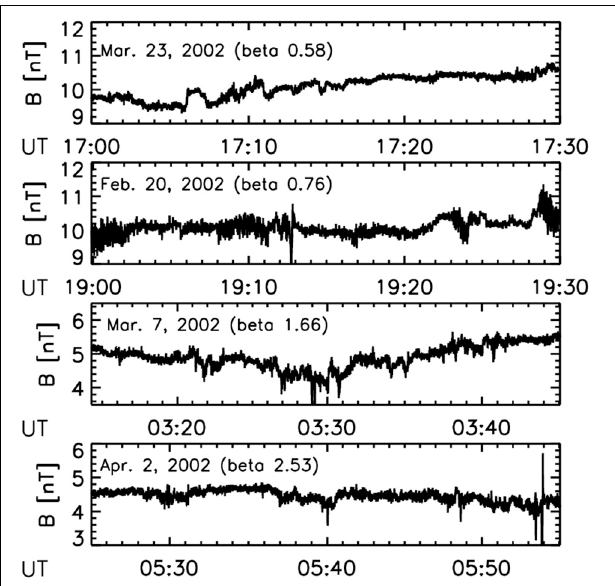
FIGURE 1 | Time series of magnetic field fluctuations (field magnitude) measured by Cluster-1 spacecraft in the solar wind ahead of Earth’s bow